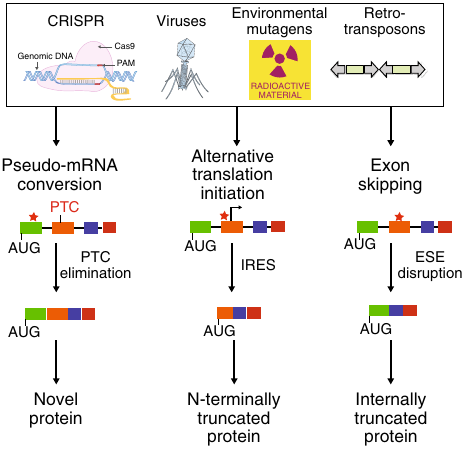
Fig. 6 Cellular mechanisms for countering INDEL effects revealed by CRISPR failures. INDELs introduced by Cas9 and other enzymes used for gene editing elicit transcriptional and translational responses that may have evolved to buffer the transcriptome and proteome against common environmental